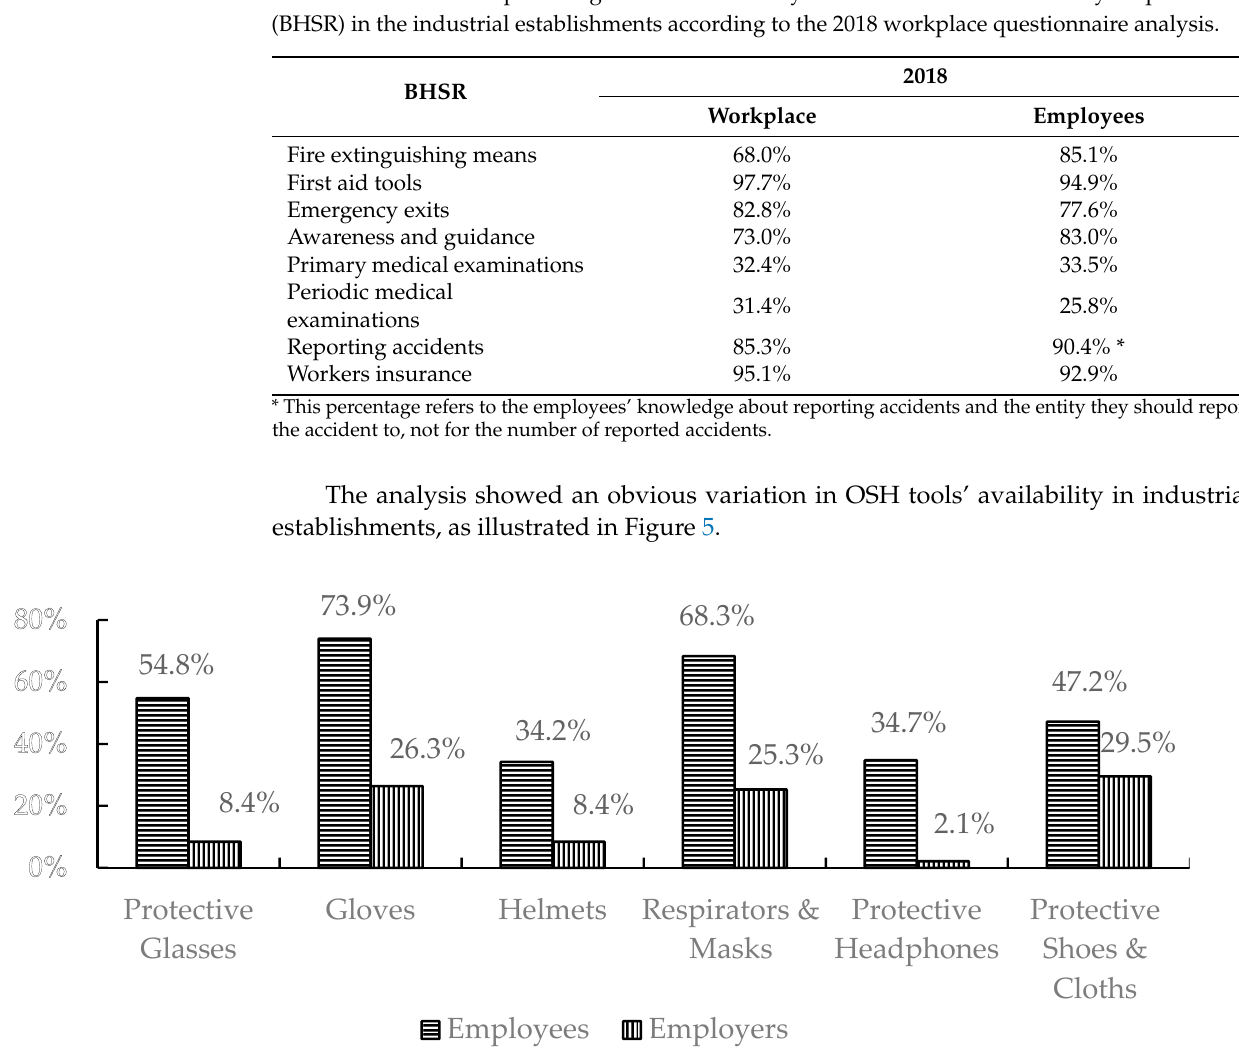
Figure 5. Percentages of OSH tools’ existence according to both employees’ and workplace survey analysis.